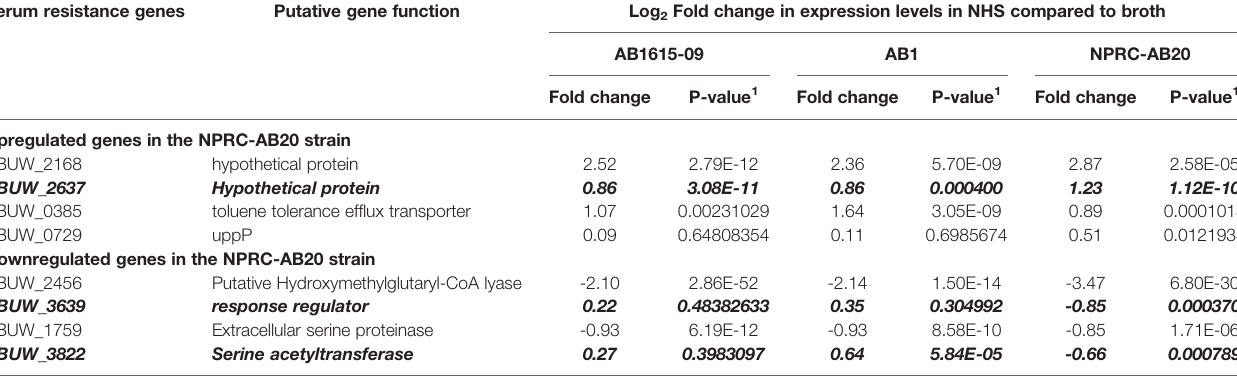
TABLE 3 | Transcriptome data for complement resistance genes showing genes with differential expression in human sera compared to nutrient rich media in the complement resistant NPRC-AB20 strain and the intermediate sensitivity AB1615-09 and AB1 strains. Serum resistance genes Putative gene function Log 2 Fold change in expression levels in NHS compared to